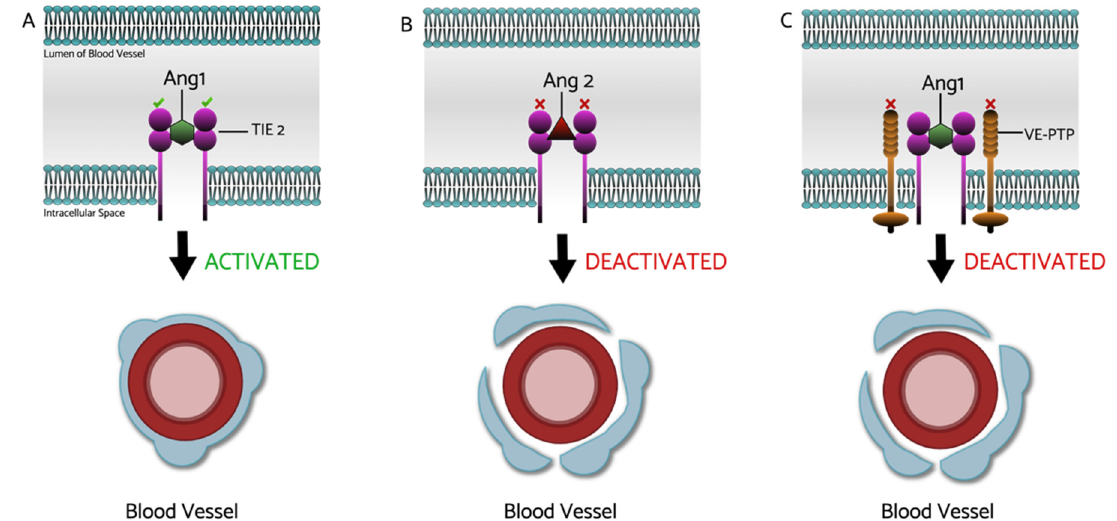
Figure 2. The Molecular Mechanism of Tie2/Ang. ( A ) The Binding of angiopoietin-1 (Ang1) to the tyrosine kinase 2 (Tie2) receptor is thought to enhance vascular stability by encouraging the recruitment and adhesion of peri-endothelial support cells and, as a result, allow the blood vessel(s) to maintain its normal form and function [88,89]. ( B ) The Prescence of angiopoietin-2 (Ang2), which competitively inhibits Ang1 on the Tie2 receptor, and ( C ) the presence of vascular endothelial protein tyrosine phosphatase (VE-PTP) receptors in the phospholipid bilayer are both understood to decrease the adherence of peri-endothelial support cells to the matrix and endothelial cells, thus making the blood vessel(s) more permeable and/or potentially undergo harmful angiogenesis [84,90].